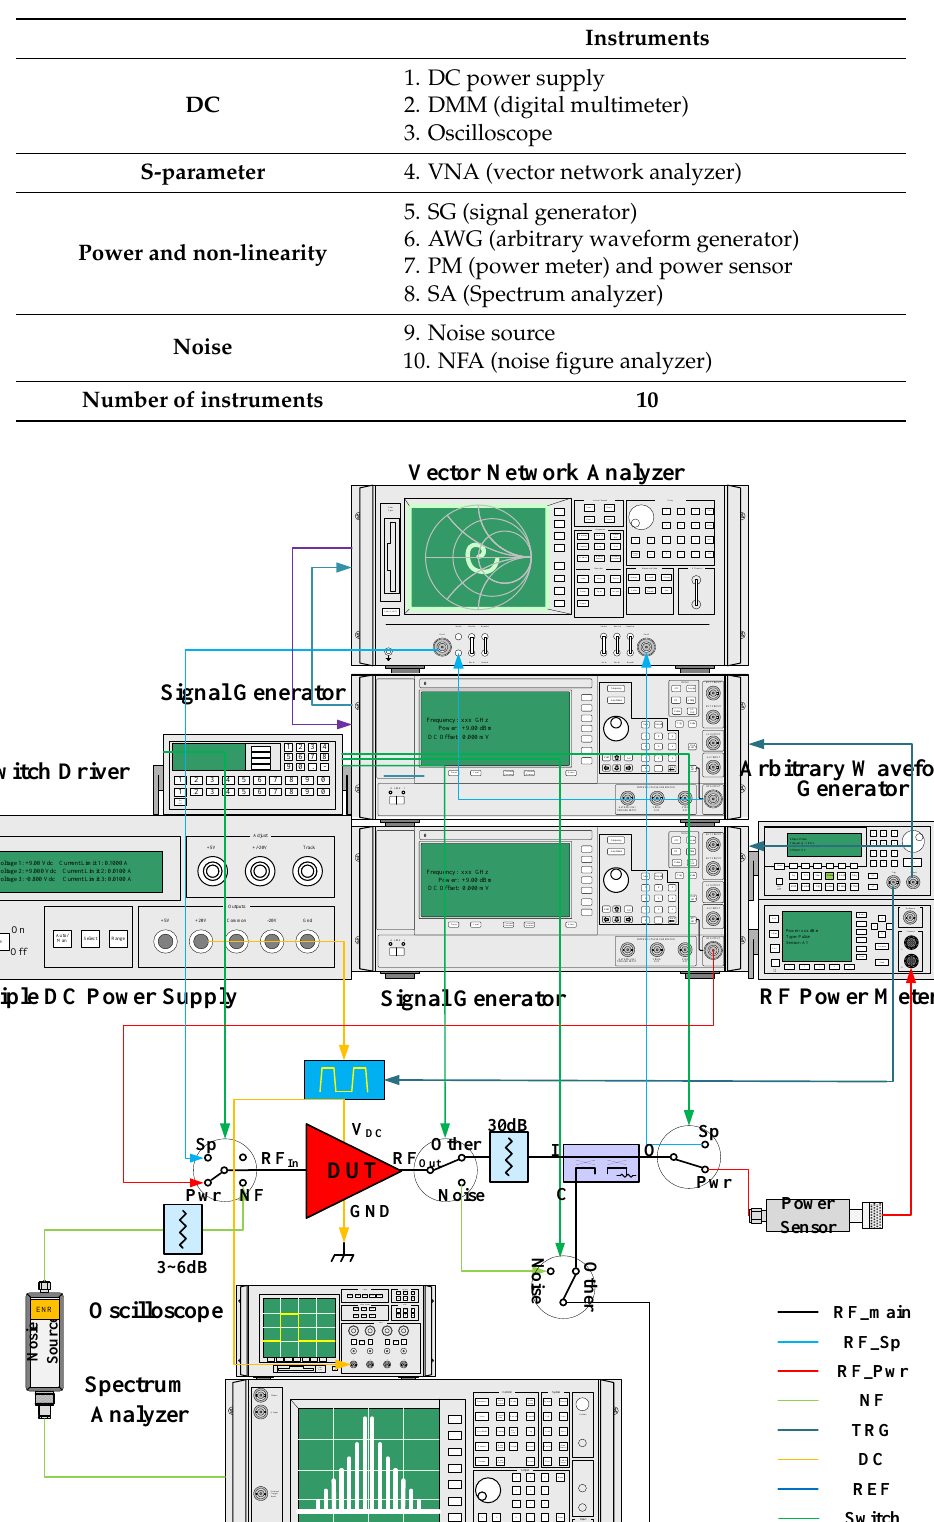
Table 3. Subsystem and their instruments.